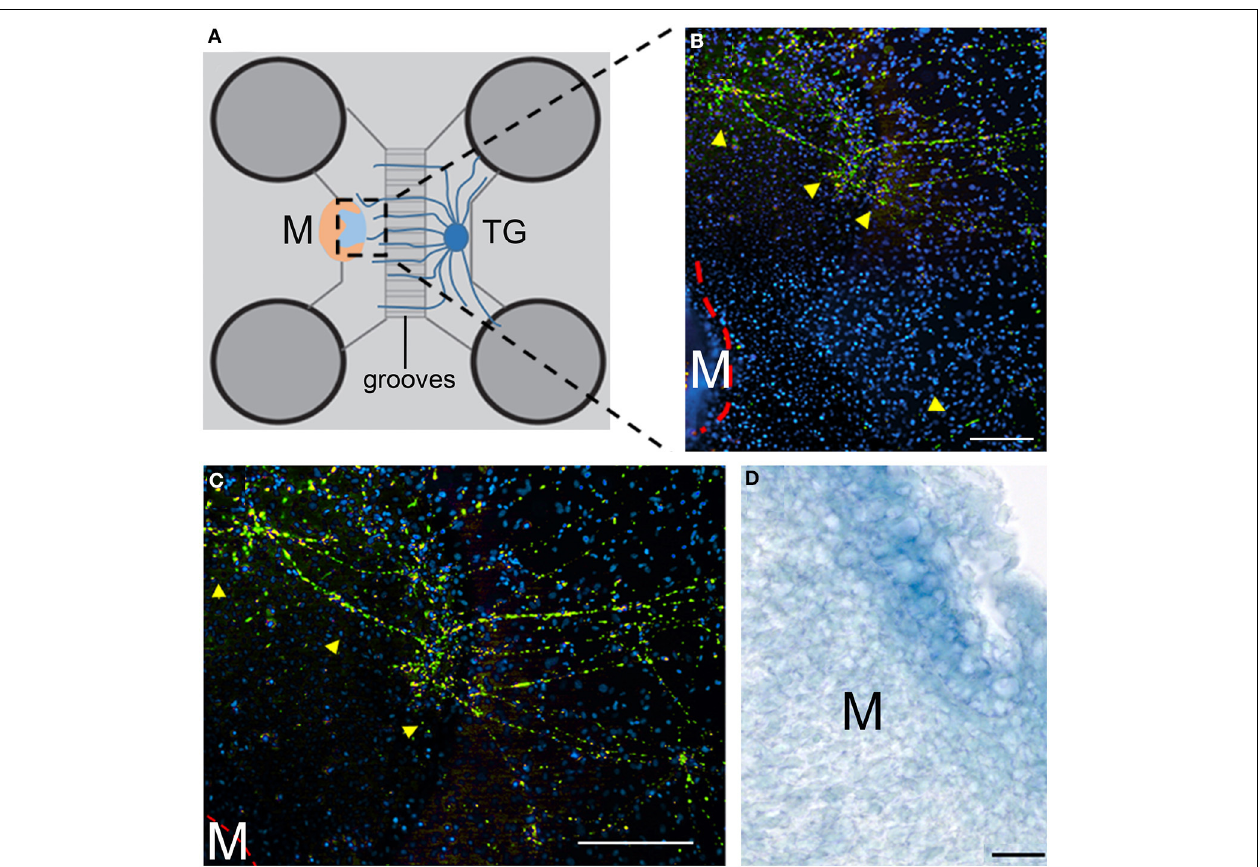
FIGURE 4 | Co-culture of trigeminal ganglia (TG) and embryonic molars in a microfluidic co-culture system. (A) Schematic representation showing the co-culture of E15.5 trigeminal ganglia and E17.5 molars in the microfluidics chamber. The tooth is oriented with the pulp facing the ganglion. (B) Neurites (yellow arrows) grow toward the developing tooth (red line) but do not contact the tooth. Green: